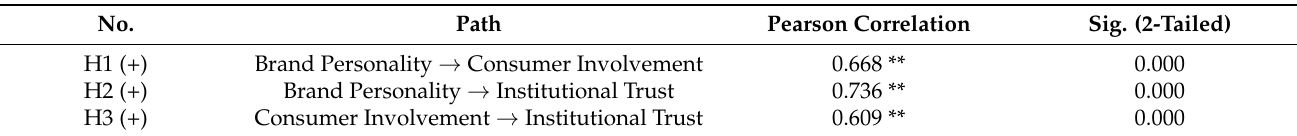
Table 4. Hypotheses testing results.